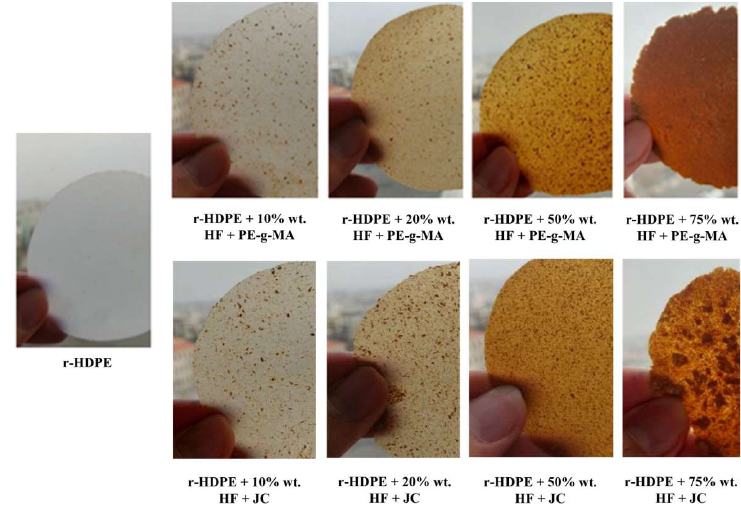
Figure 1. Illustration of recycled high-density polyethylene (r-HDPE) and r-HDPE + hemp fiber (HF) composite materials with different compatibilizers (polyethylene-grafted maleic anhydride (PE-g-MA) or Joncryl (JC)).